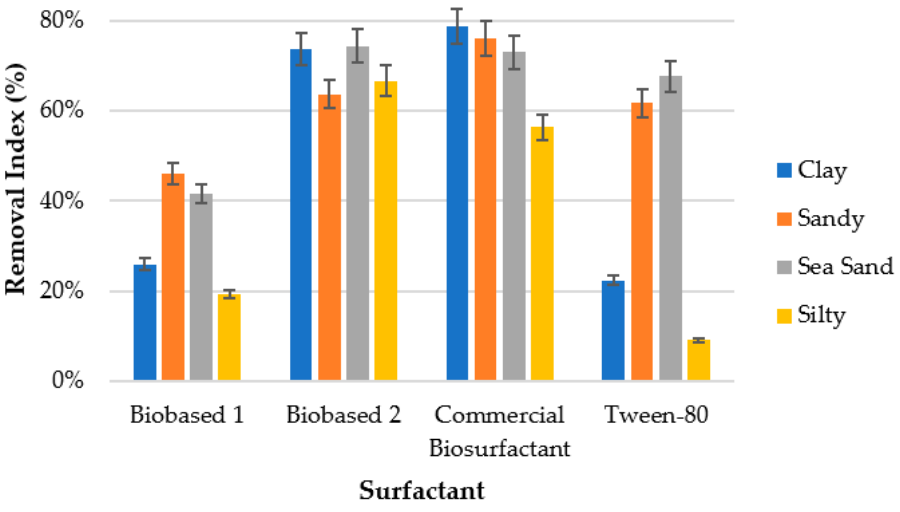
Figure 8. Removal of motor oil adsorbed to four types of soils in flasks (kinetic assay) using the four surfactants tested.